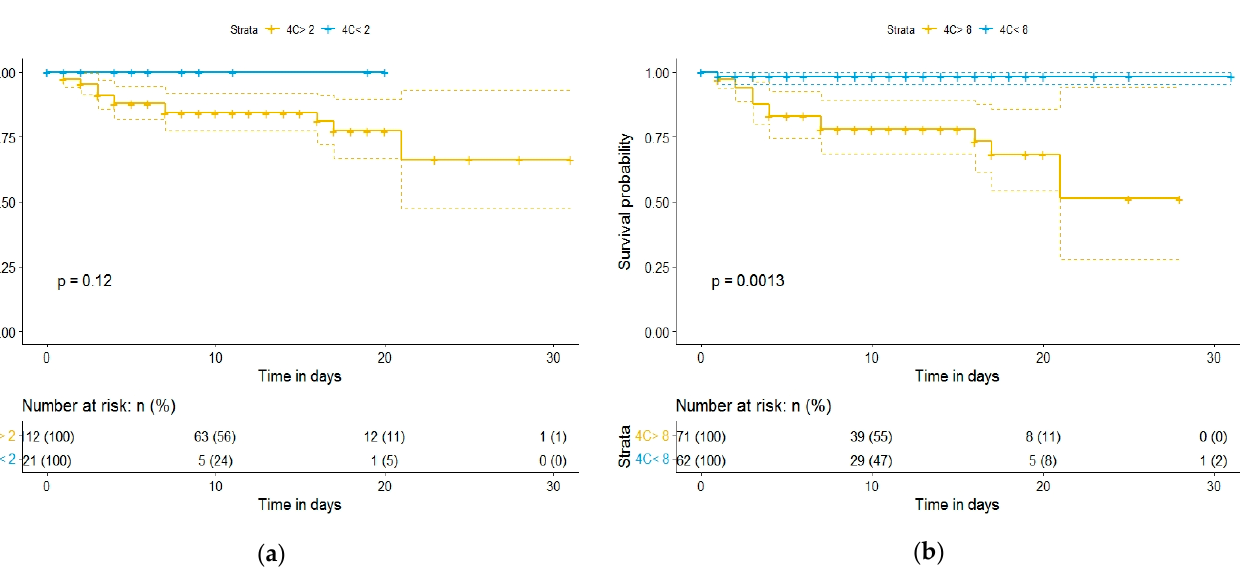
( b ) Figure 3. Kaplan–Meier survival curves of hospitalized COVID-19 patients: ( a ) according to 4C Mortality Score cutoff value of 11; ( b ) according to 4C Mortality Score cutoff value of 14. In addition, differences in patient survival by 4C Mortality Score classification showed highly statistically significant differences ( p < 0.001) (Figure 4).